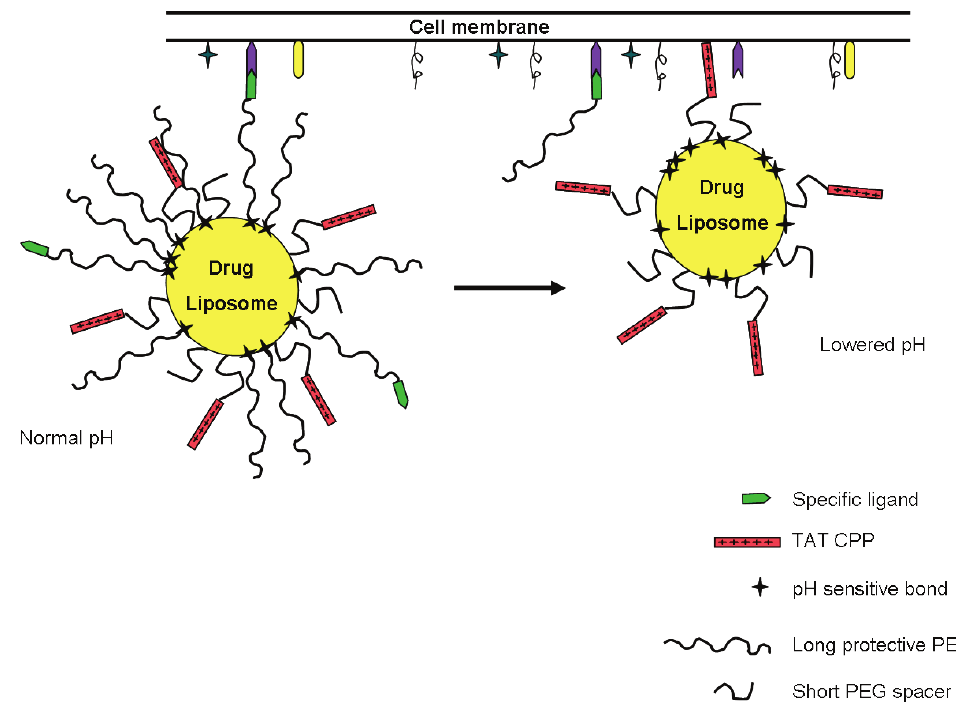
Figure 6. Interaction of the multifunctional pH-responsive pharmaceutical nanocarrier with the target cell [138]. A decrease of pH in the tumor environment induces the hydrolysis of the hydrazone bond, thereby exposing the CPP, which helps the delivery system to enter the tumoral